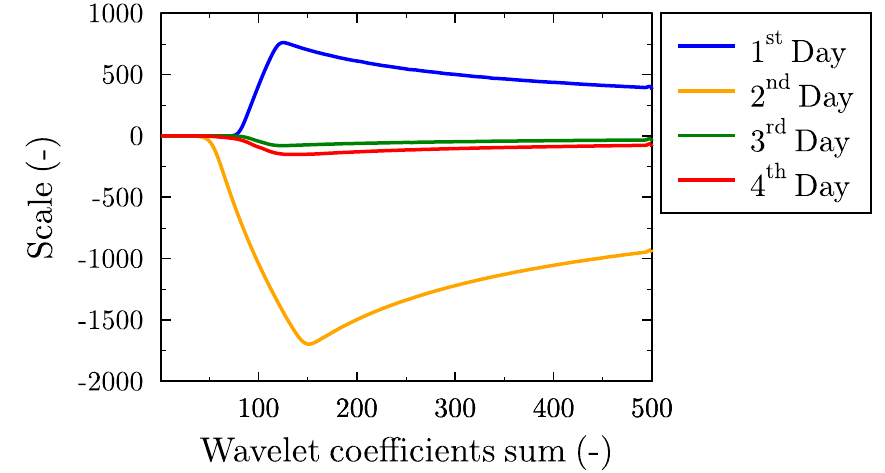
Figure 8. Curves representing sums of wavelet coefficients. Each curve was obtained as a result of summing up wavelet coefficients after the application of the Continuous Wavelet Transform of HR signals for a selected volunteer during four days of measurement programme. Different colours indicate a particular measurement day: 1st day, one day preceding the extreme physical effort; 2nd day, the day of the effort; 3rd day, one day following the effort, 4th day, two days following the